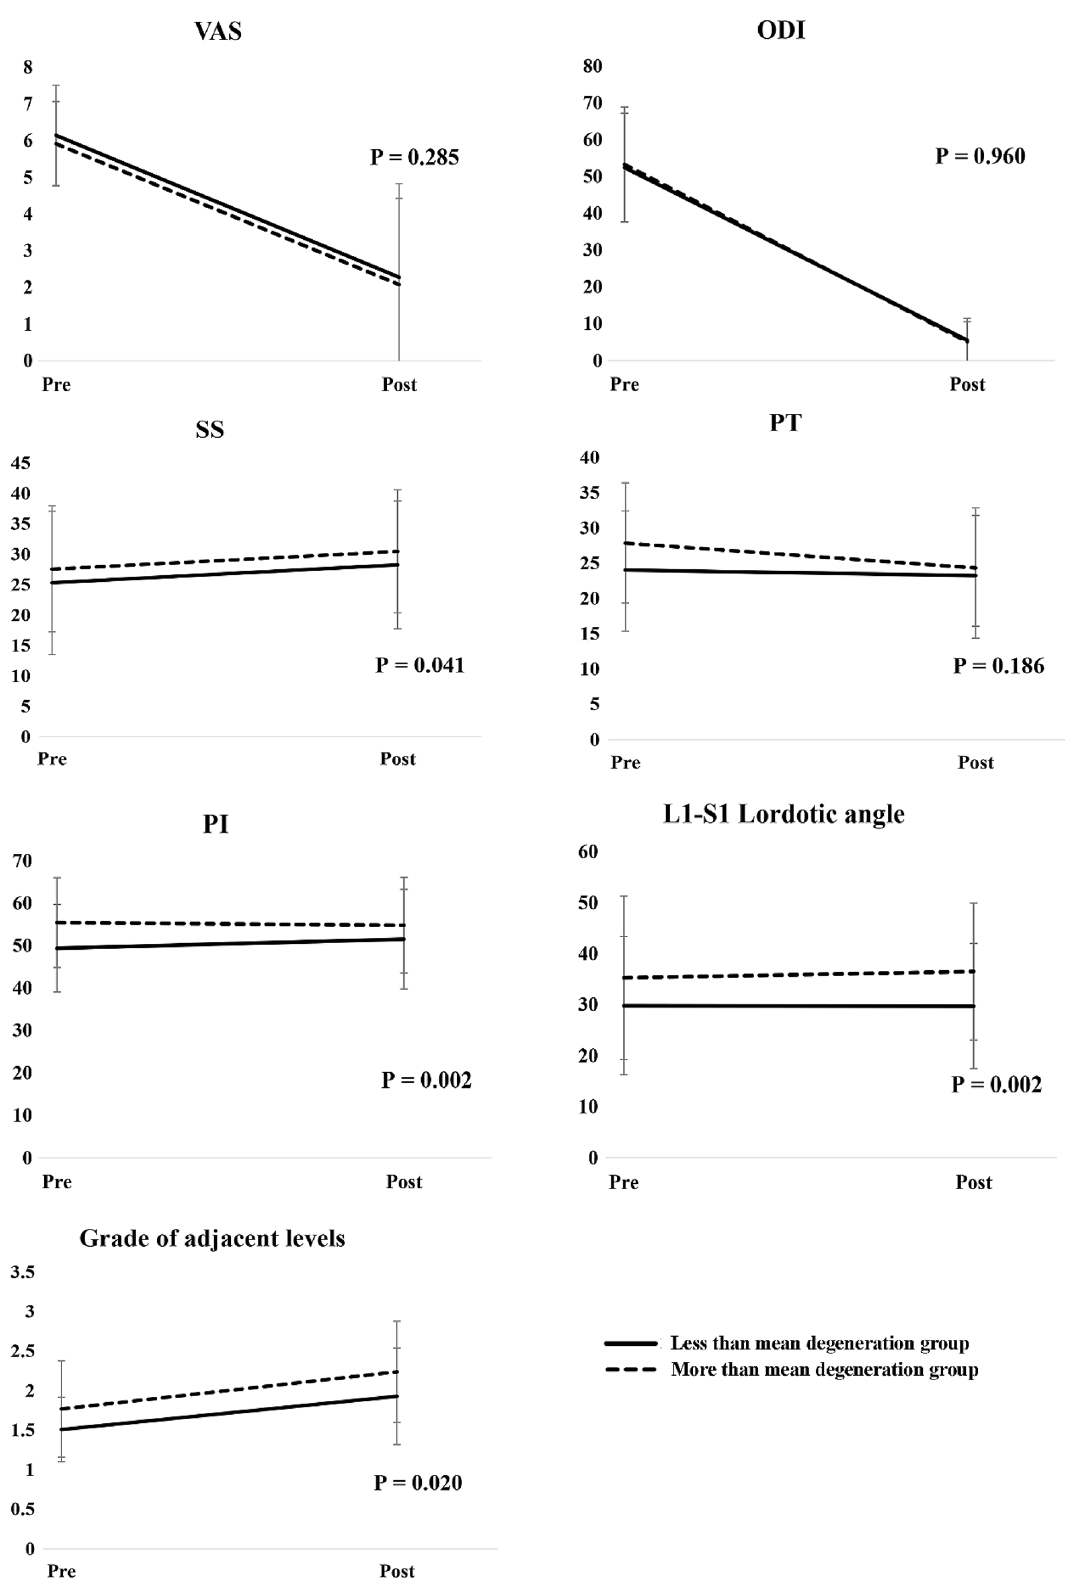
Figure 2. Changes in clinical characteristics before and after operation, stratified by mean preoperative degeneration score. The p-value was calculated based on a mixed-effect model after adjusting for